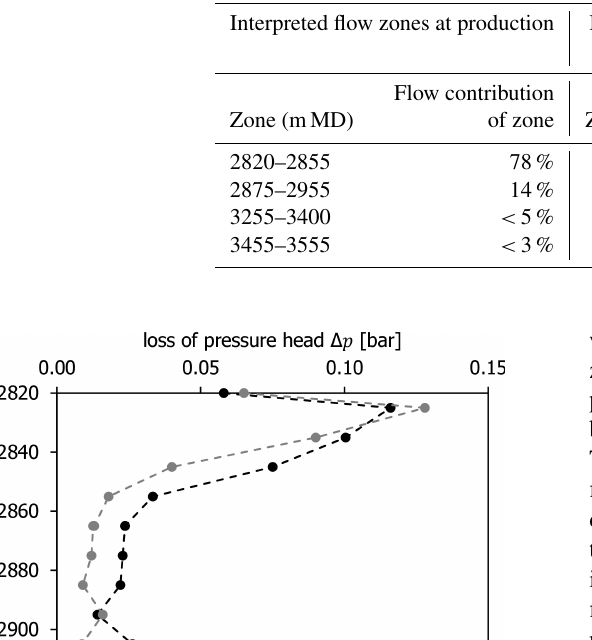
Table 2. Comparison of flow zones interpreted from DTS production data with flow zone interpretation from flow meter data at injection.